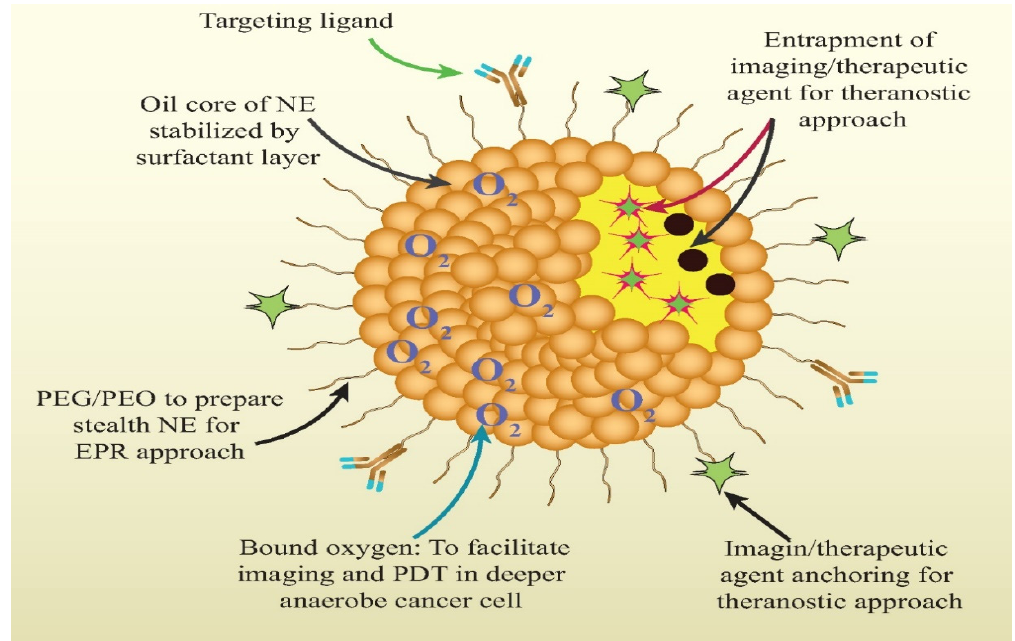
Figure 5. Brief depiction of how lipidic theranostic can help in cancer alleviation via multi-functionalized aspects such as coupling of the surface with targeting ligand; entrapped theranostic agent, PEG coating on the surface for evading systemic clearance, bound oxygen for enhancing photothermal therapy, surface anchored contrasting agent.